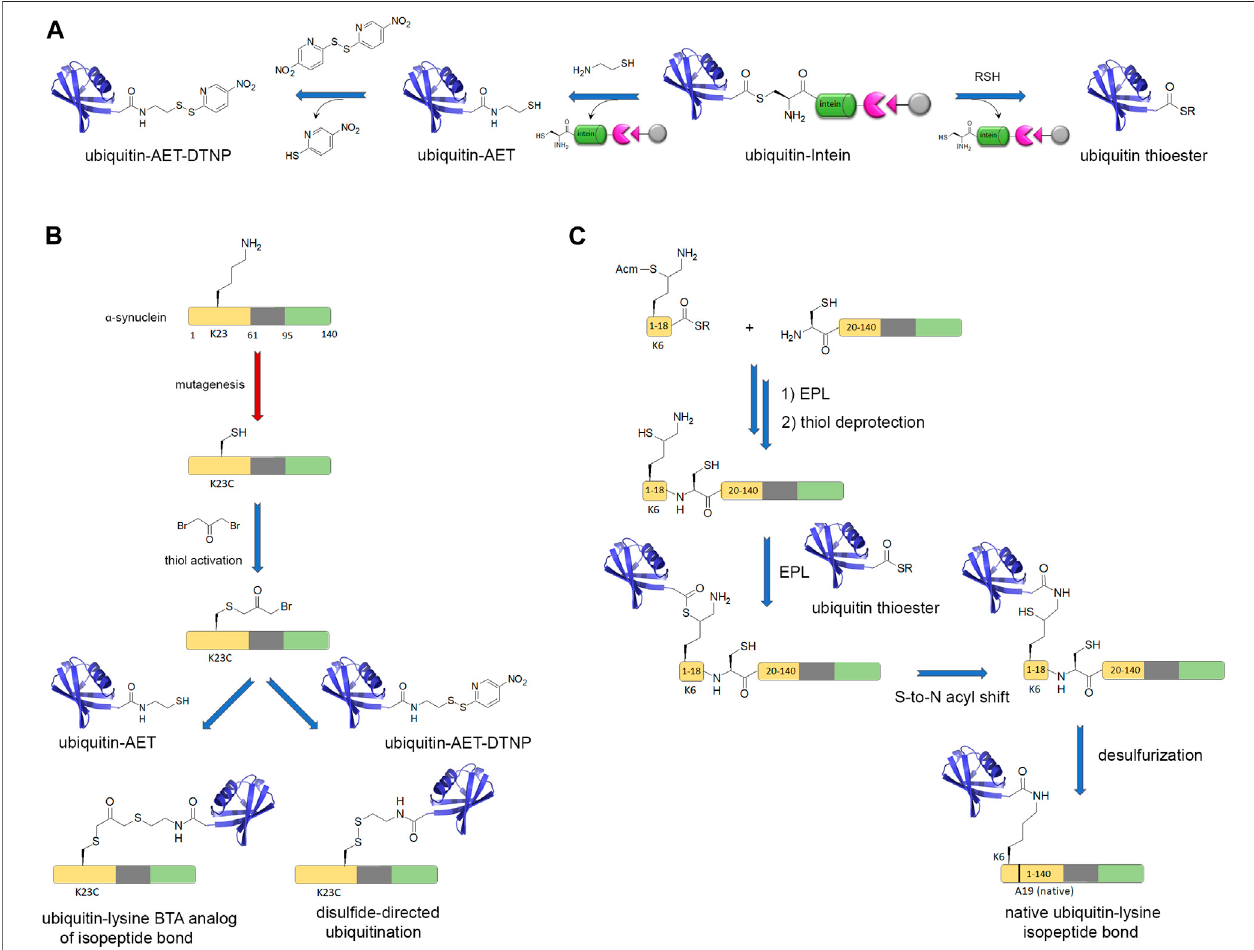
FIGURE4| Chemicalbiologystrategiesofproteinubiquitination. (A) PosttranslationalchemicalmutagenesisandEPLapproachesinvolveboththepreparationofa C-terminal activated ubiquitin from a ubiquitin-intein fusion protein that provides a reactive C-terminal thioester. (B) Posttranslational chemical mutagenesis exempli fi ed for K23 ubiquitination of α -synuclein requires fi rst the thiol activation of a cysteine residue obtained by site-directed mutagenesis at the PTM site. The activated thiol is further involved in a reaction with ubiquitin-aminoethanethiol (ubiquitin-AET) leading to a bis-thio-acetone (BTA) analog of the ubiquitin-lysine isopeptide bond (Lewis et al., 2016). Alternatively, a ubiquitin-AET activated by 2,2 ′ -dithiobis(5-nitropyridine) (ubiquitin-AET-DTNP) can react with the cysteine thiol in a disul fi de-directed ubiquitination (Moon et al., 2020). (C) The EPL strategy involves fi rst, the synthesis of full-length α -synuclein by EPL of two fragments, a N-terminal peptide (fragment 1 – 18) bearing a protected δ -mercaptolysine at position K6 for further ubiquitin linkage and a C-terminal recombinantly expressed fragment with a N-terminal cysteine. After NCL and thiol deprotection of the δ -mercaptolysine, EPL with the recombinantly expressed ubiquitin with C-terminal thioester and subsequent desulfurization provide the full-length, native α -synuclein with a native ubiquitin-lysine isopeptide bond (Hejjaoui et al., 2011). Chemical reactions are indicated by blue arrows and enzymatic reactions by red arrows.